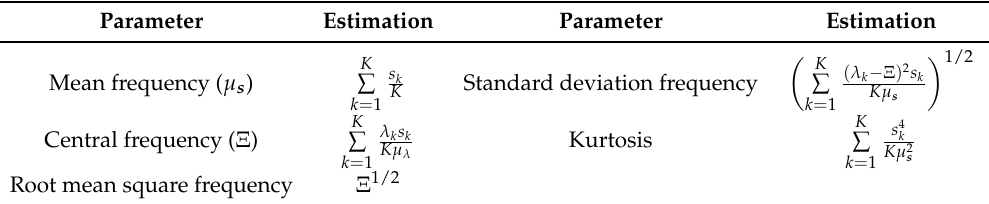
Table 2. Frequency domain features ( F ). Frequency-based parameters are computed for each pair frequency and spectrum vectors λ , s ∈ R K